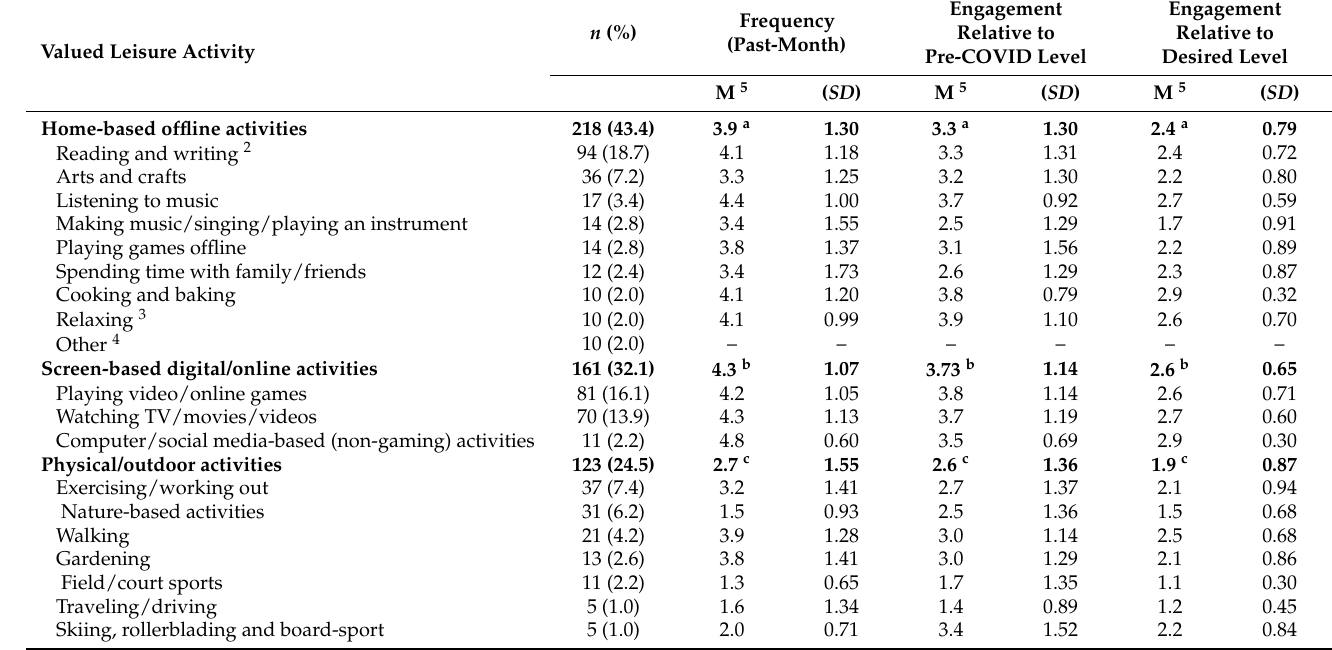
Table 2. Descriptive data on self-identified valued leisure activity ( n = 502) 1